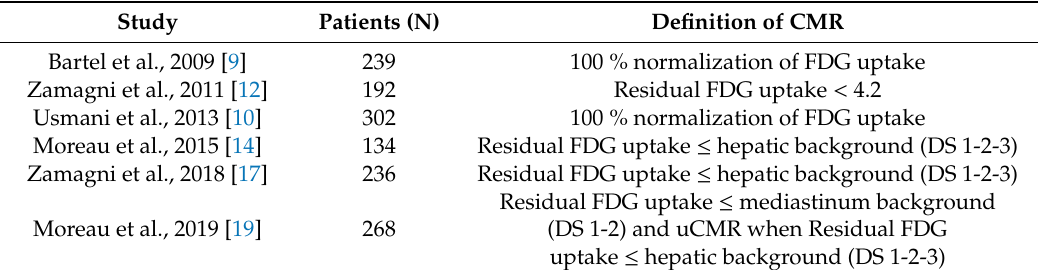
CMR indicates complete metabolic response; Fls: focal bone lesions; EMD: extra-medullary disease; FDG-PET / CT: 18F-fluorodeoxyglucose-positron emission tomography with computed tomography; DS: Deauville scale; uCR: uncertain complete metabolic